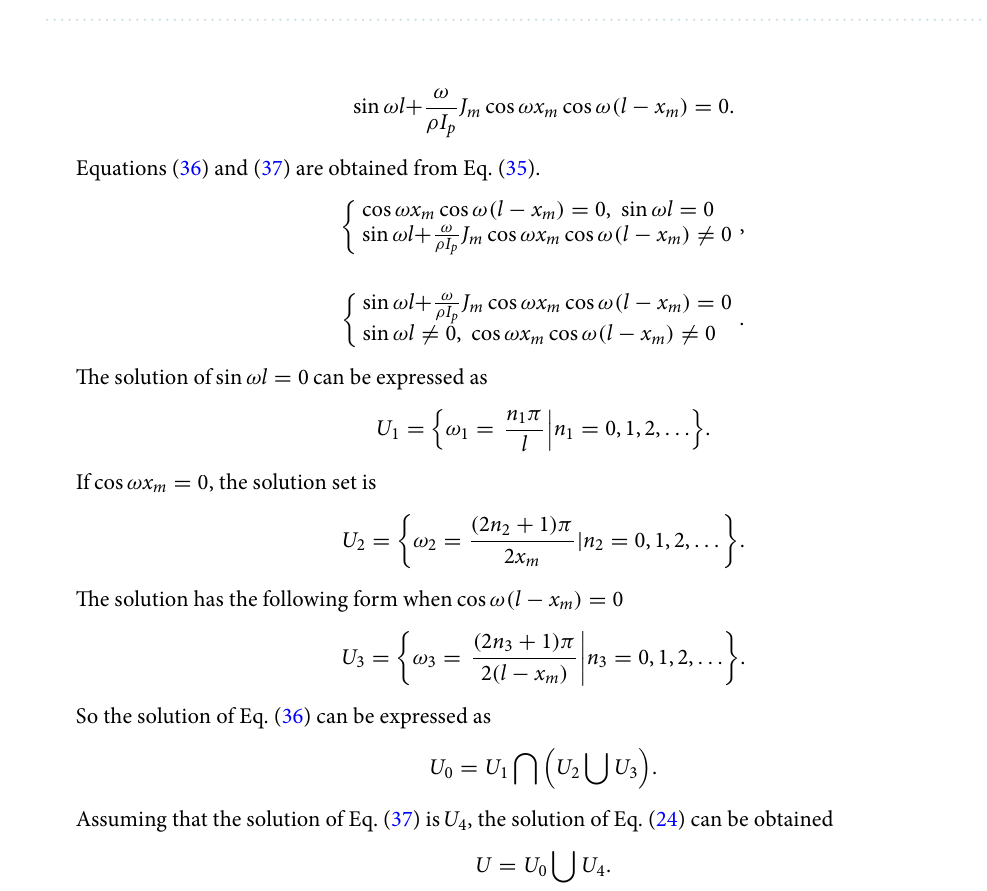
Figure 21. The shaft carrying single concentrated inertia J m located at x m = l / 4